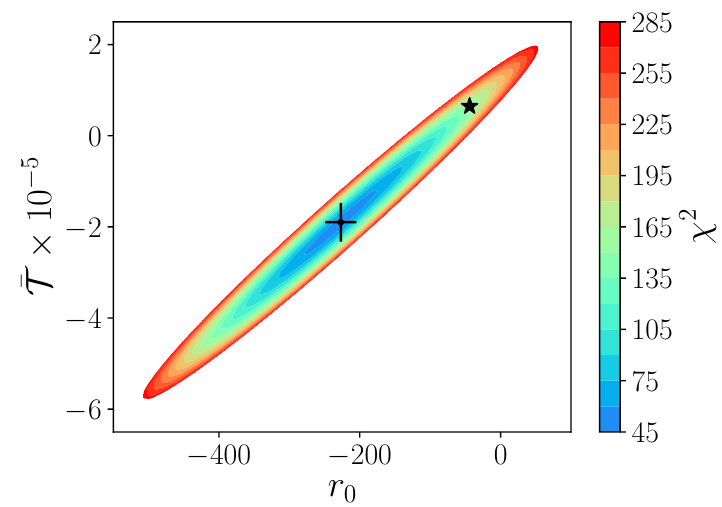
Figure 11. χ 2 heat map that corresponds to the global fit at order L − 6 without priors, taking both EC and RC into account. The fit interval is [10 , 24] , and a 0 is fixed to 0.439. The black data point with error bars marks the corresponding fit results for r 0 and ¯ T , cf. table 6. The black star marks the perturbative